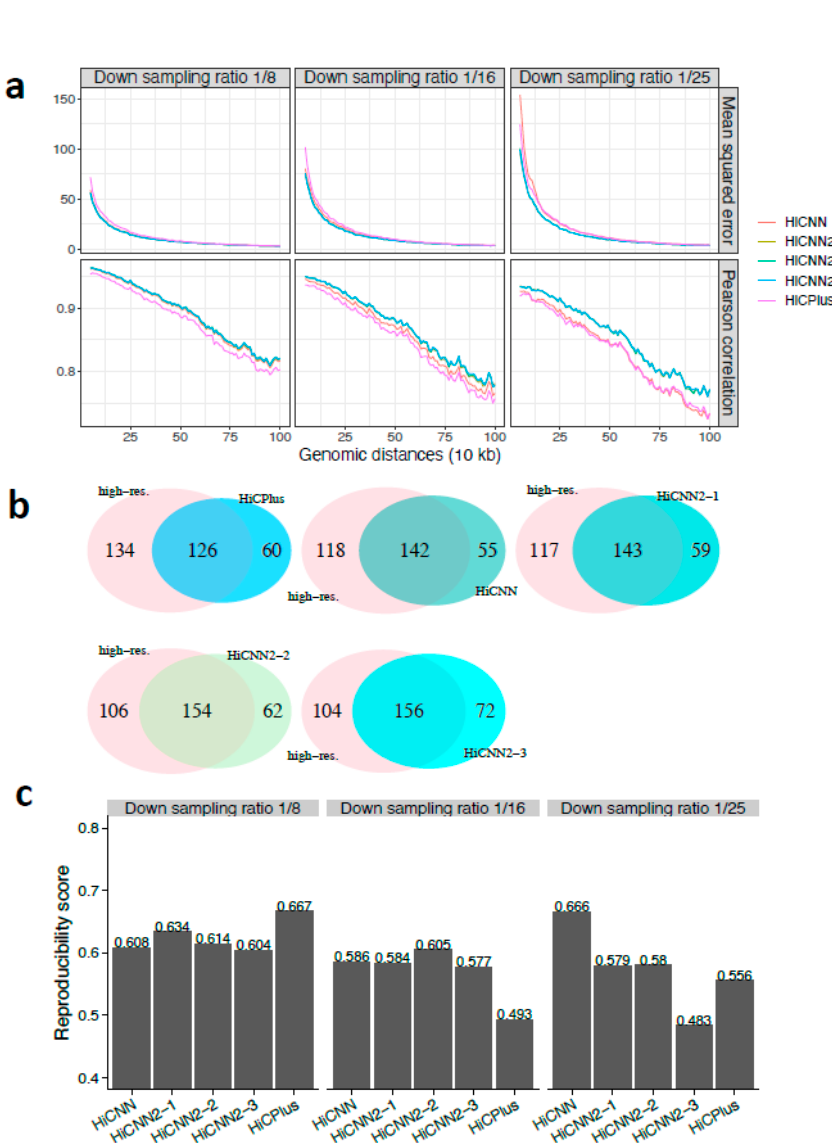
Figure 3. The evaluation results on chromosome 10 in human K562 cells between experimental high-resolution Hi-C (10 kb resolution) and each of the five predicted Hi-C data sets, namely, HiCPlus-enhanced, HiCNN-enhanced, HiCNN2-1-enhanced, HiCNN2-2-enhanced, and HiCNN2-3-enhanced: ( a ) mean squared error and Pearson’s correlations with three different down-sampling ratios (1/8, 1/16, and 1/25); ( b ) the effectiveness of recovering significant interactions (detected by Fit-Hi-C with q -value < 0.05 within the genomic distances from 50 kb to 2 Mb) with a down-sampling ratio of 1/8; and ( c ) the reproducibility scores with the three down-sampling ratios.